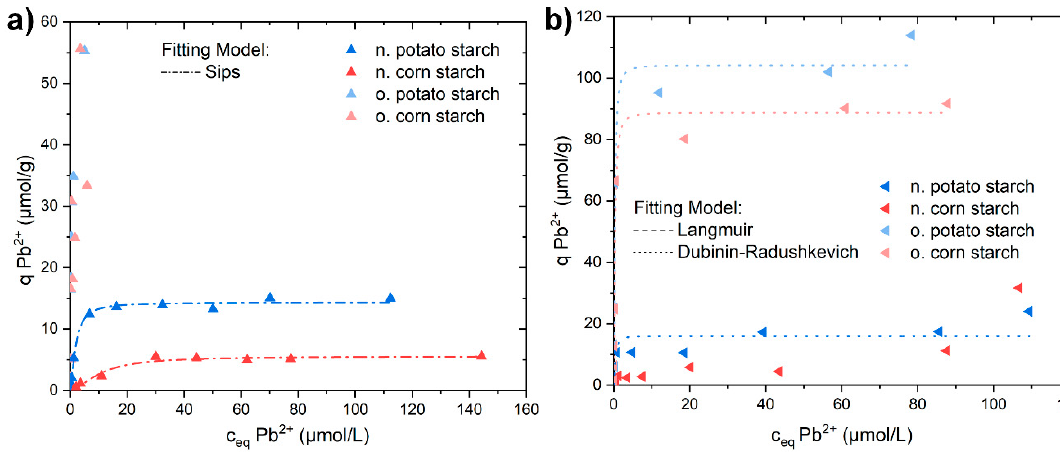
Figure 11. ( a ) Adsorption isotherm of Pb 2+ from PbSO 4 solution with adsorbent dosage of 100 mg/30 mL and corresponding Sips isotherm model fits. Native potato starch is shown in blue, native corn starch in red, oxidized potato starch in light blue, and oxidized corn starch in pink. The corresponding SO 42 − adsorption and pH values can be seen in Figure S24. ( b ) Adsorption isotherm of Pb 2+ from PbSO 4 solution with decreased adsorbent dosage of 10 mg/30 mL and corresponding Dubinin–Radushkevich isotherm model fits. Native potato starch is shown in blue, native corn starch in red, oxidized potato starch in light blue, and oxidized corn starch in pink. The corresponding SO 42 − adsorption and pH values can be seen in Figure S25. Table 7. Fitting parameters for Langmuir, Sips, and Dubinin–Radushkevich isotherm models for adsorption with de- creased adsorbent dose from PbSO 4 solution. Q m thereby is the maximal sorption capacity, K is the equilibrium constant for the respective model, and E ads,DR is the mean free energy of adsorption derived from the Dubinin–Radushkevich model. To the isotherm of native corn starch, no applied model gave a reasonable fit.